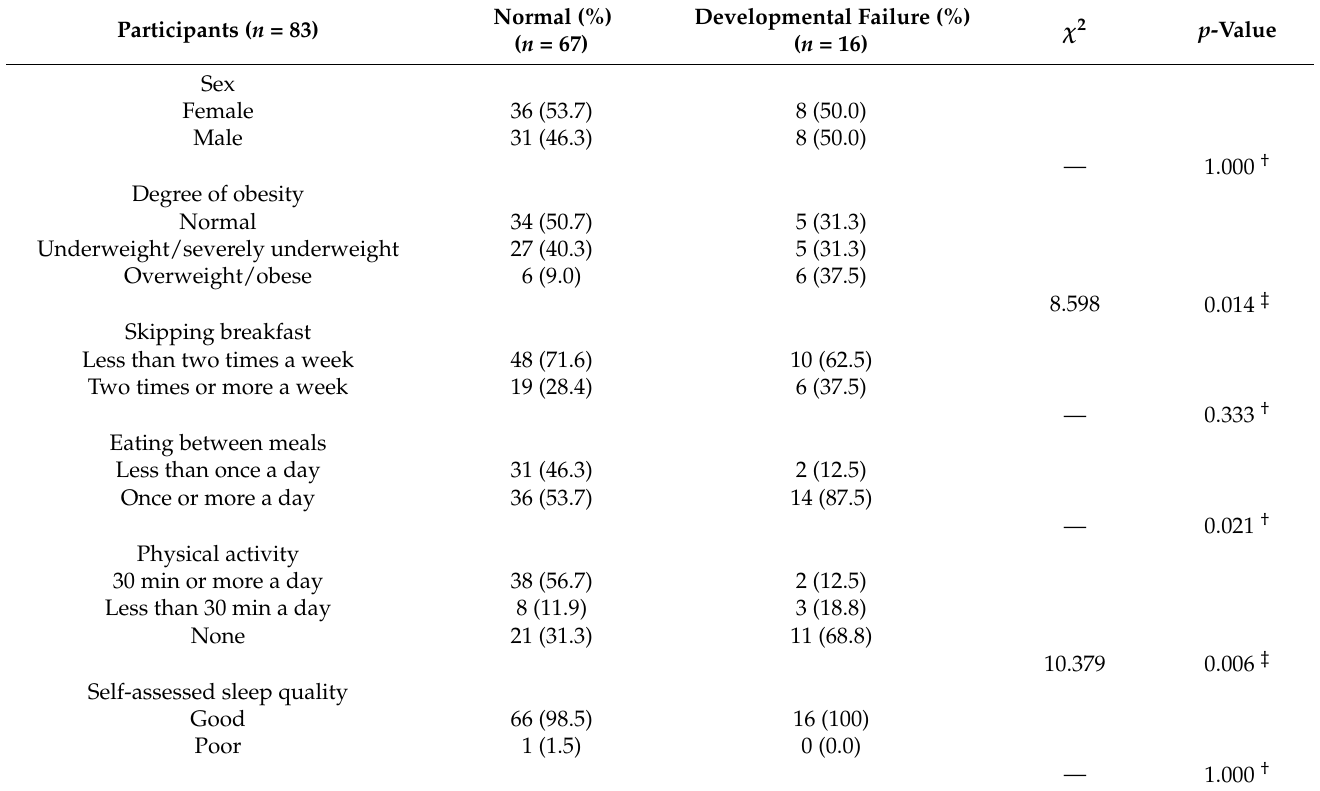
Table 4. Cross-tabulation analysis between the development of swallowing threshold and sex and health-related